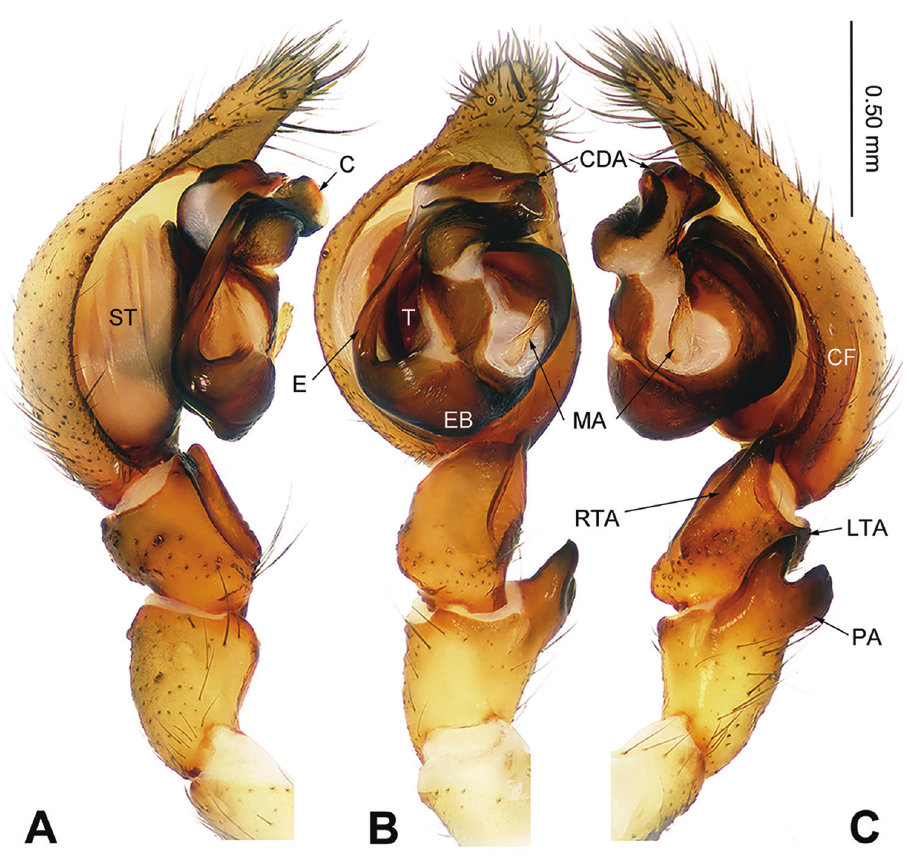
Figure 7. Left male palp of Sinodraconarius patellabifidus A Prolateral view B Ventral view C Retrolateral view. Scale bar equal for A, B, C